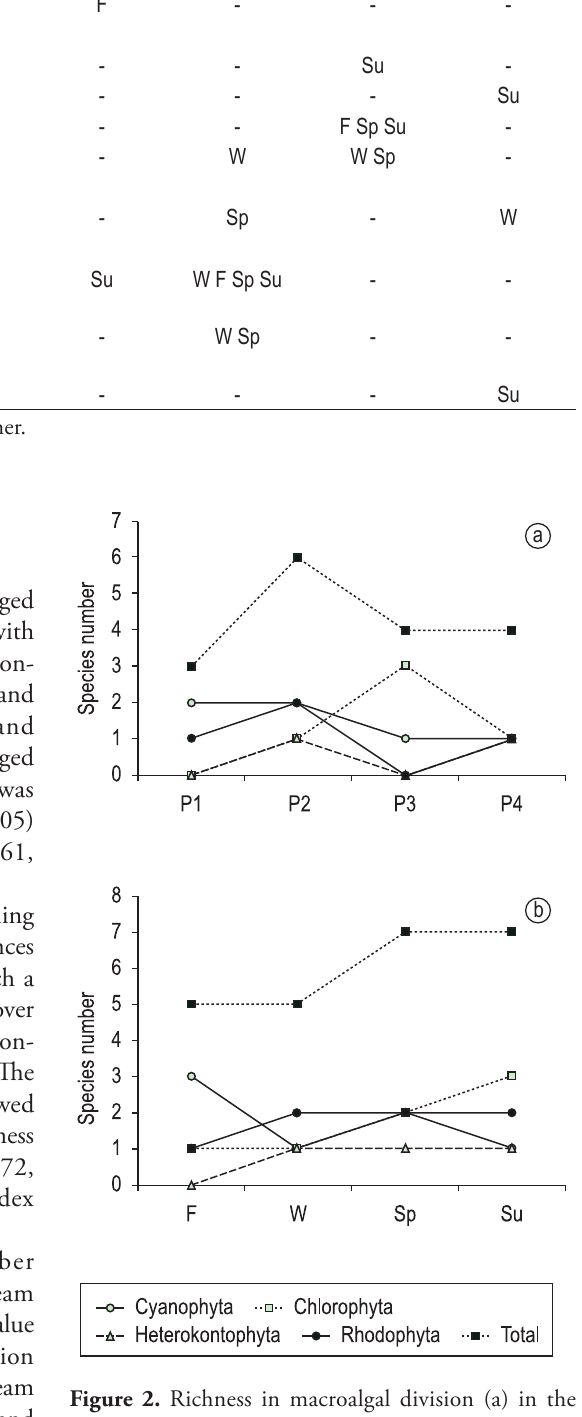
Figure 2. Richness in macroalgal division (a) in the sampling sites and (b) seasons in the Cascavel Stream, Guarapuava, Paraná State. F = Fall, W = Winter, Sp = Spring and, Su =